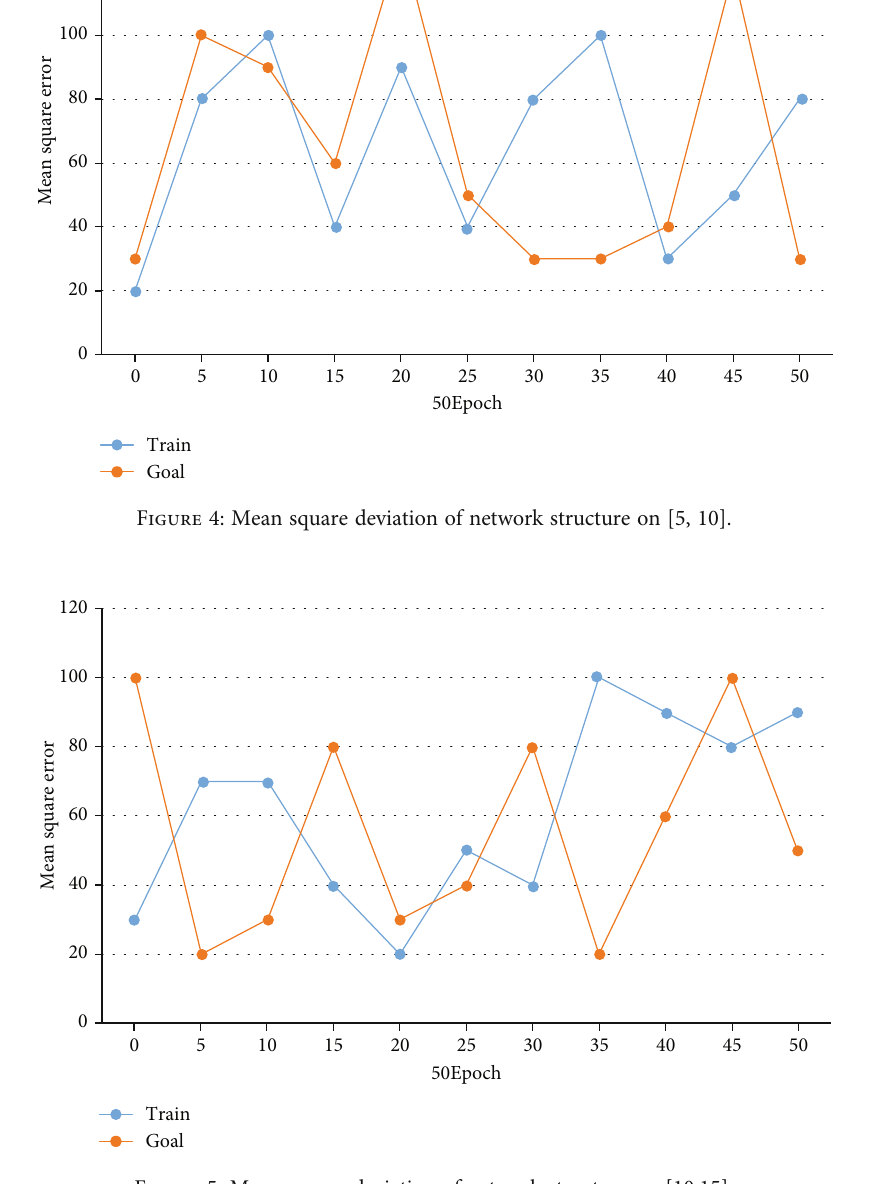
Figure 5: Mean square deviation of network structure on [10,15]. Table 1: Comparison of training results of di ff erent numbers of hidden nodes. Hidden node